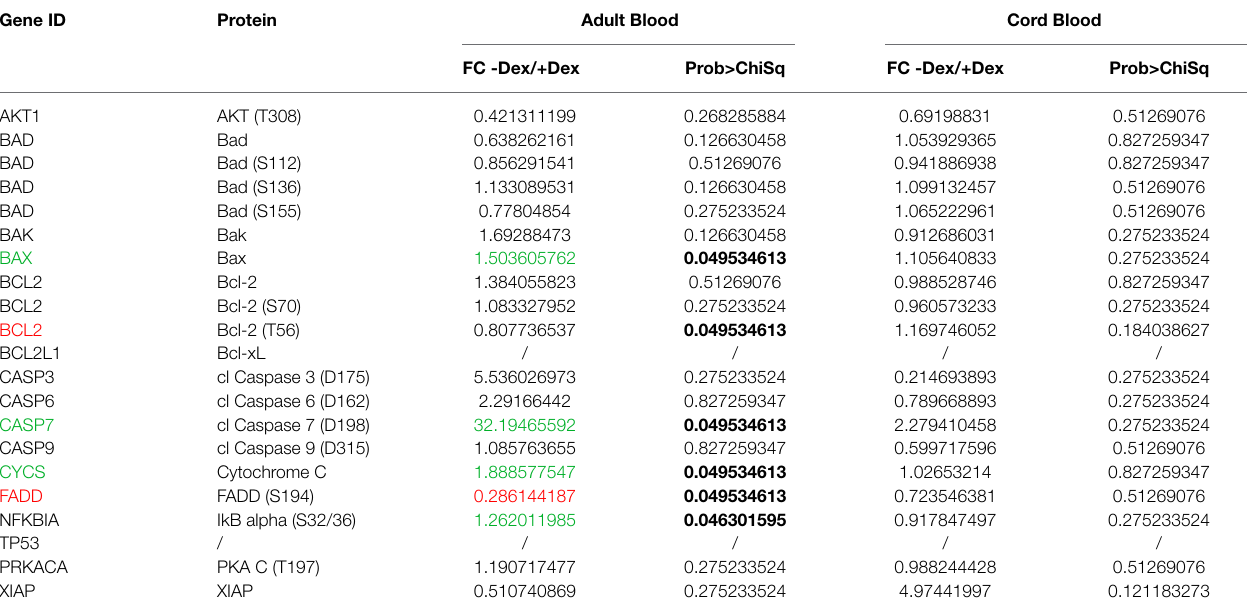
TABLE 4 | List of endpoints of the apoptosis pathway included in the RPPA array and of their fold changes in erythroid cells expanded with and without Dex either from adult blood or cord blood. Gene ID Protein Adult